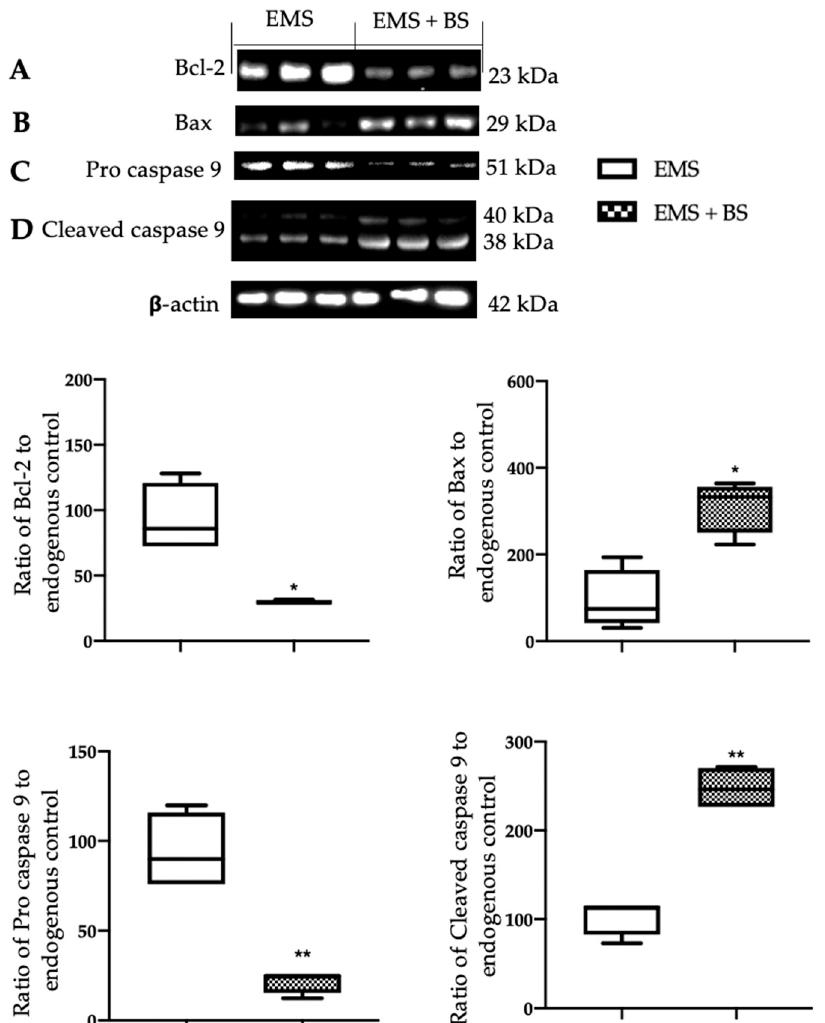
Figure 5. Analysis of the effect of oral BS administration on apoptosis: Western blot analysis of: Bcl-2 ( A ), Bax ( B ), Pro caspase 9 ( C ), cleaved caspase 9 ( D ). For the analyses, n = 5 animals from each group were employed. A p -value of less than 0.05 was considered significant. * p < 0.05 vs. control, ** p < 0.01 vs. control.